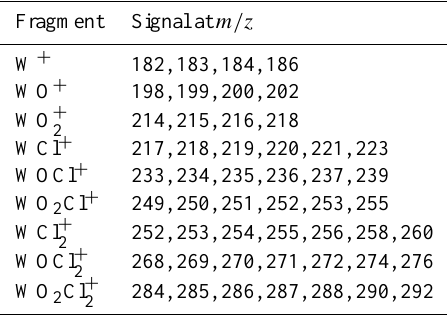
Table 3. Fragments and isotopes (only W isotopes with >1% relative abundance are considered) of tungsten oxide chloride (WO 2 Cl 2 )